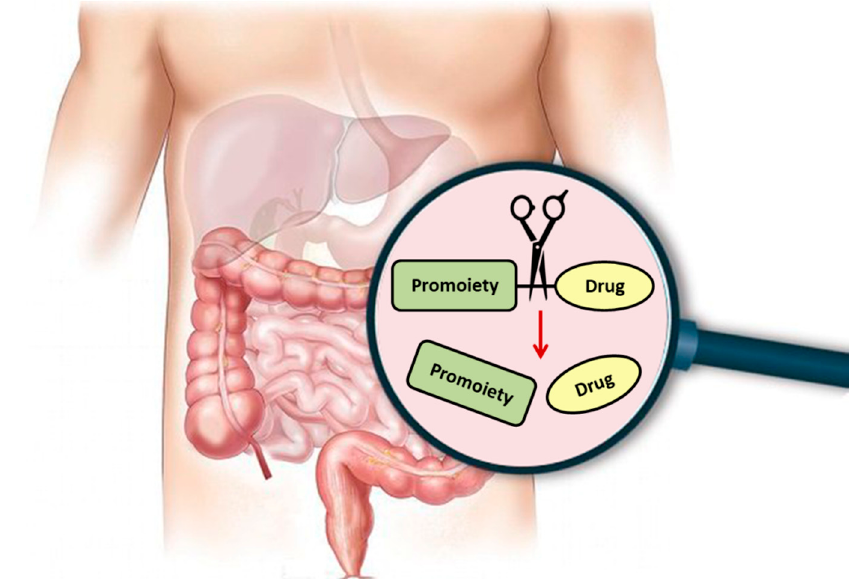
Figure 1. Illustration of activation of orally administered prodrugs in the gastrointestinal tract. Scissors represent chemical/enzymatic activation of the carrier-drug with consequent release of the reaction products: carrier and drug alone.